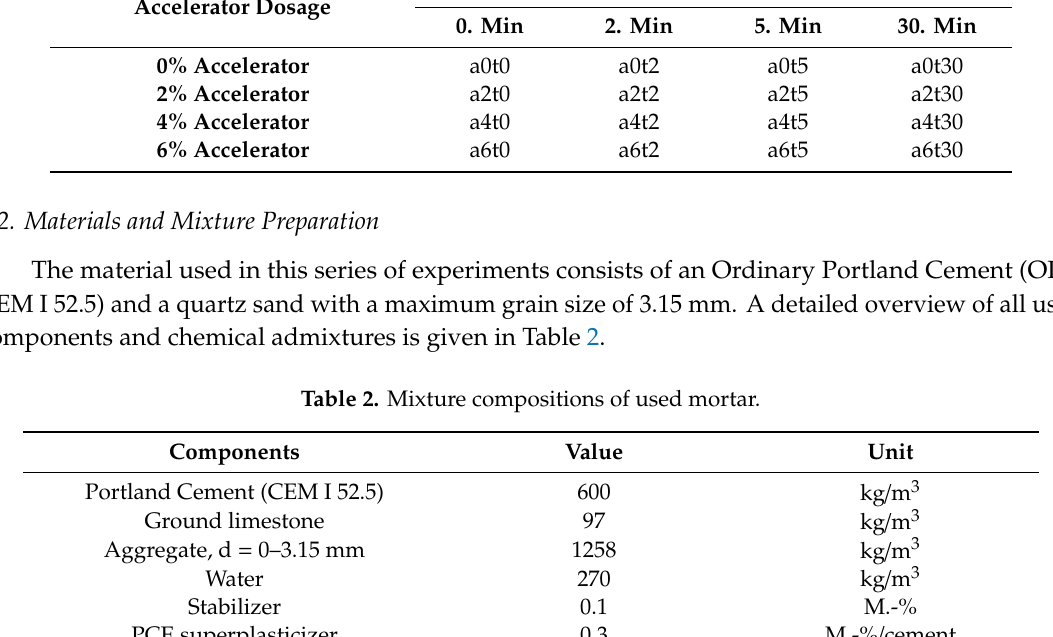
Table 1. Overview of the experiments with variations in accelerator dosage (a) and interlayer time (t). Accelerator Dosage